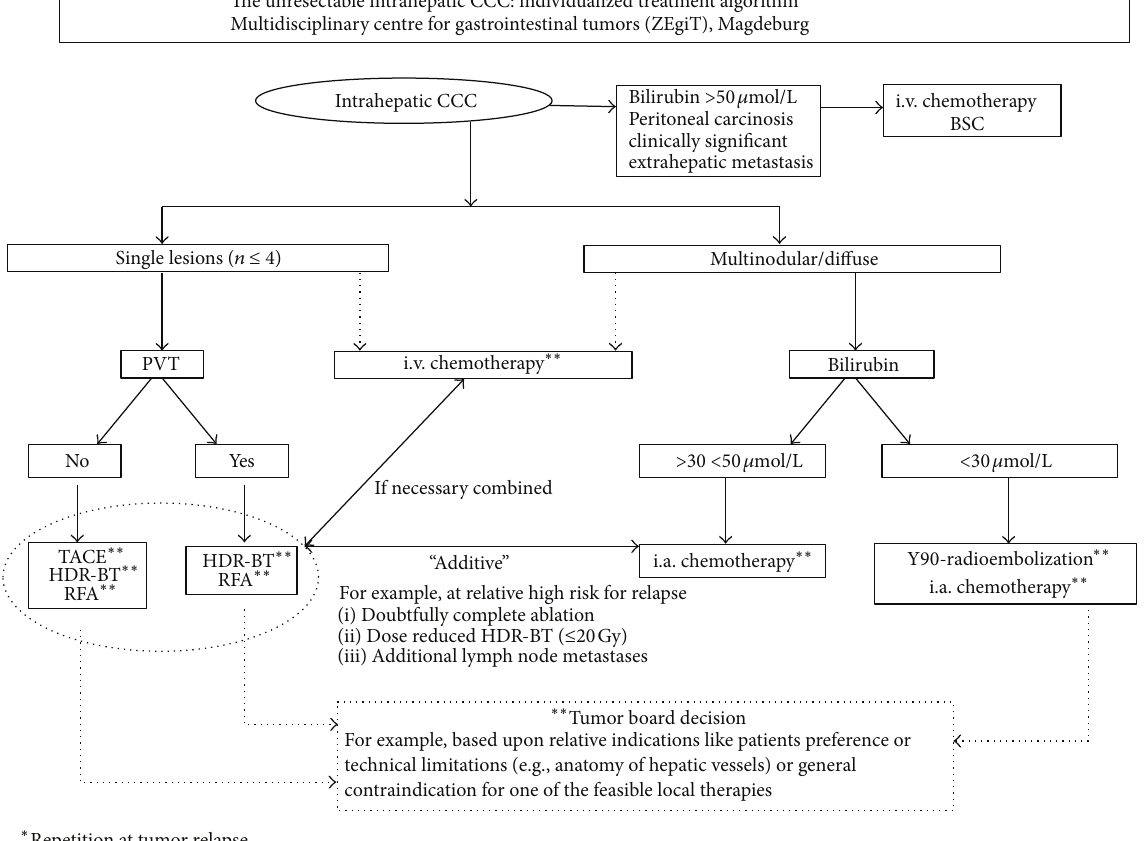
Figure 1: Algorithm for the treatment of intrahepatic cholangiocellular carcinoma. CCC, cholangiocellular carcinoma; HDR-BT, image- guided HDR brachytherapy; TACE, transarterial chemoembolization; RFA, radiofrequency ablation; i.a., intra-arterial; i.v., intravenous; BSC, best supportive care; PVT, portal venous